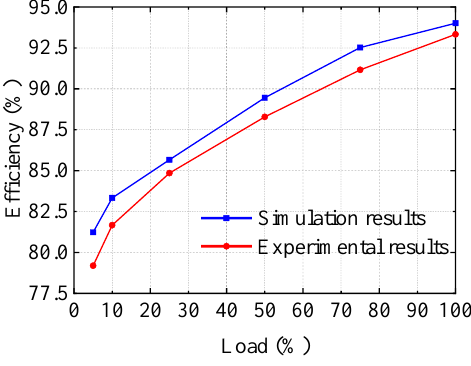
Figure 19. The curve of efficiency.